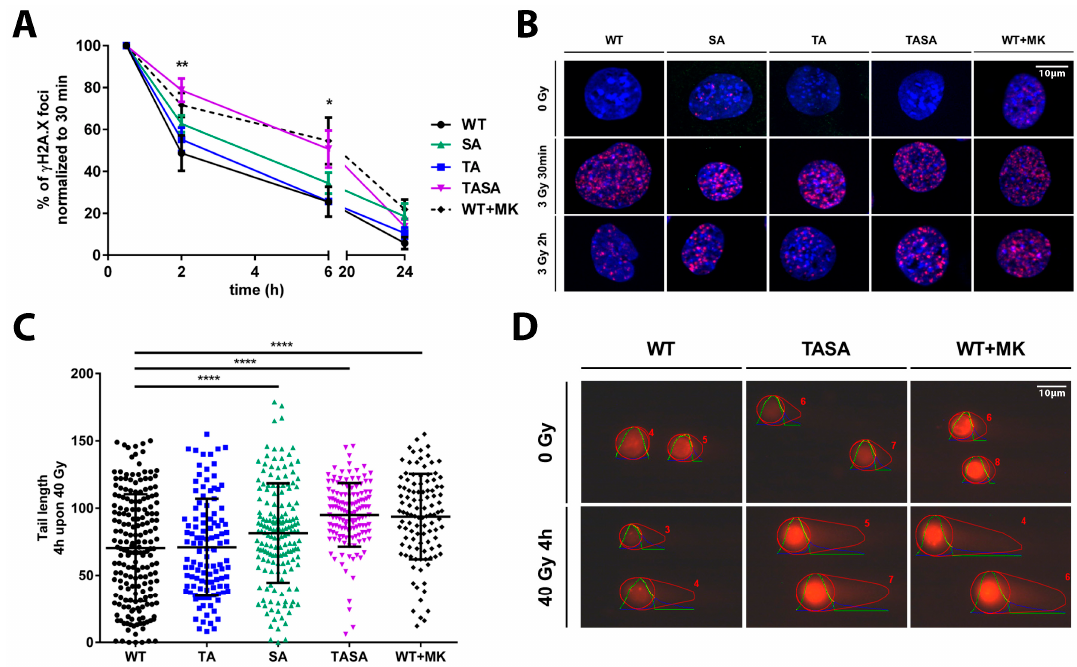
Figure 4. The genetic or pharmacologic inhibition of Akt1-phosphorylation affects DNA repair upon IR. TrC1 stably overexpressing Akt1-WT, pre-treated for 2 h with 0 or 4 µ M MK-2206, or the phosphorylation-deficient Akt1-TA, -SA or -TASA mutants were exposed to irradiation with 0 Gy, 3 Gy ( A,B ) or 40 Gy ( C,D ) as indicated. ( A , B ) Cells were fixed in 3% para-formaldehyde (PFA), permeabilized with 0.2% Triton X-100 in phosphate-buffered saline (PBS) at distinct time points between 0 h and 24 h upon irradiation with 3 Gy, and stained with Hoechst33342, to visualize the nuclei (blue), and γ H2A.X (magenta), to visualize sites of DNA DSB. ( A ) The number of γ H2A.X foci at 2–24 h after irradiation with 3 Gy using the Focinator v 2.2. software [20] was normalized to the number of foci detected at 0.5 h time point. ( C , D ) Cells were processed by applying neutral comet assay to quantify the amount of damaged DNA in the form of DSB at a fixed time-point. The quantification was performed by the OpenComet software and depicts the comet tail length of each indicated Akt1 mutant 4 h upon 40 Gy. ( A , C ) Data show means ± SD from 3 independent experiments with 50 analyzed nuclei per trial and condition. * p < 0.05, ** p < 0.01, *** p < 0.001, **** p < 0.0001; ANOVA test with Tukey correction. ( B , D ) Data show representative pictures out of 3 independent